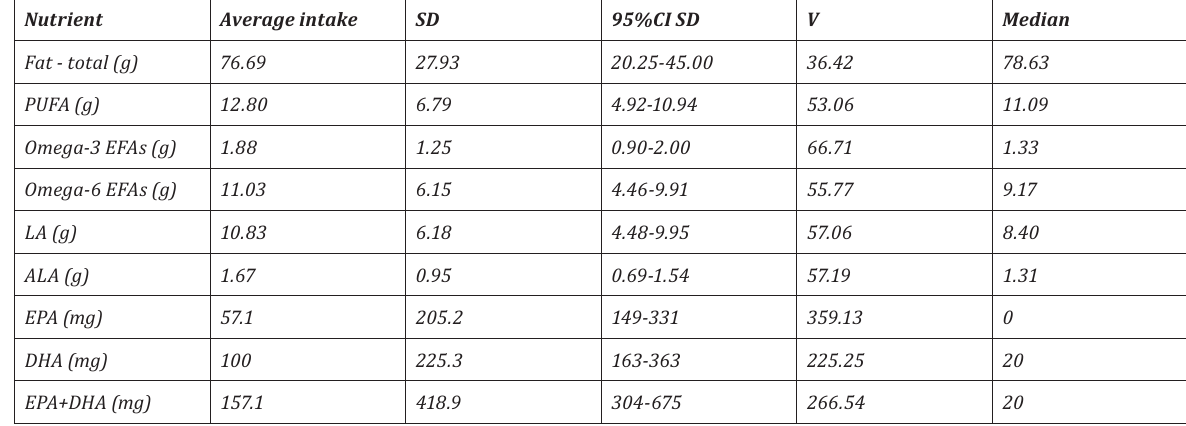
SD - standard deviation; 95% CI - 95% confidence interval; V- coefficient of variation; p-value - statistical significance - women vs men. *p<0.05 Table 6. Fat intake in the women group